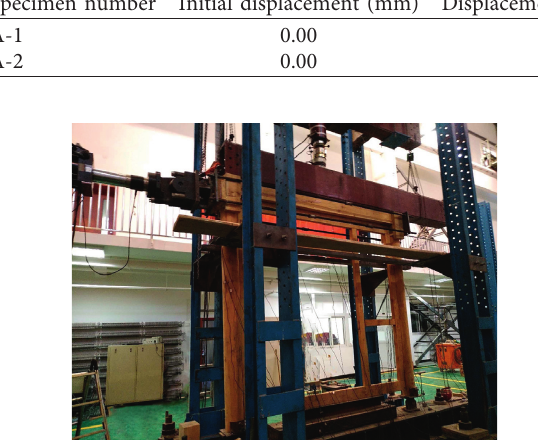
Figure 8: Vertical and horizontal loading devices.